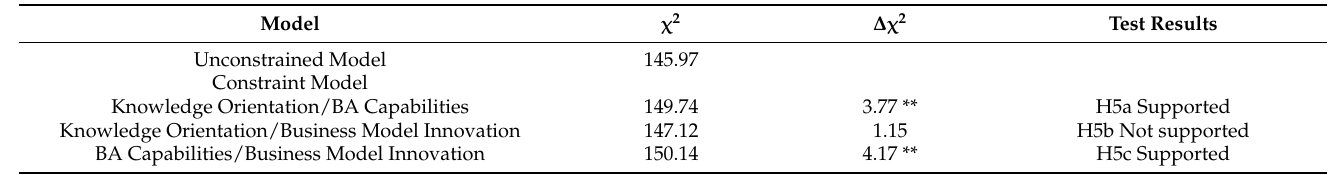
Table 6. Test results of the moderating effect of industry type on the relationship between knowledge orientation, BA capabilities, and business model innovation.